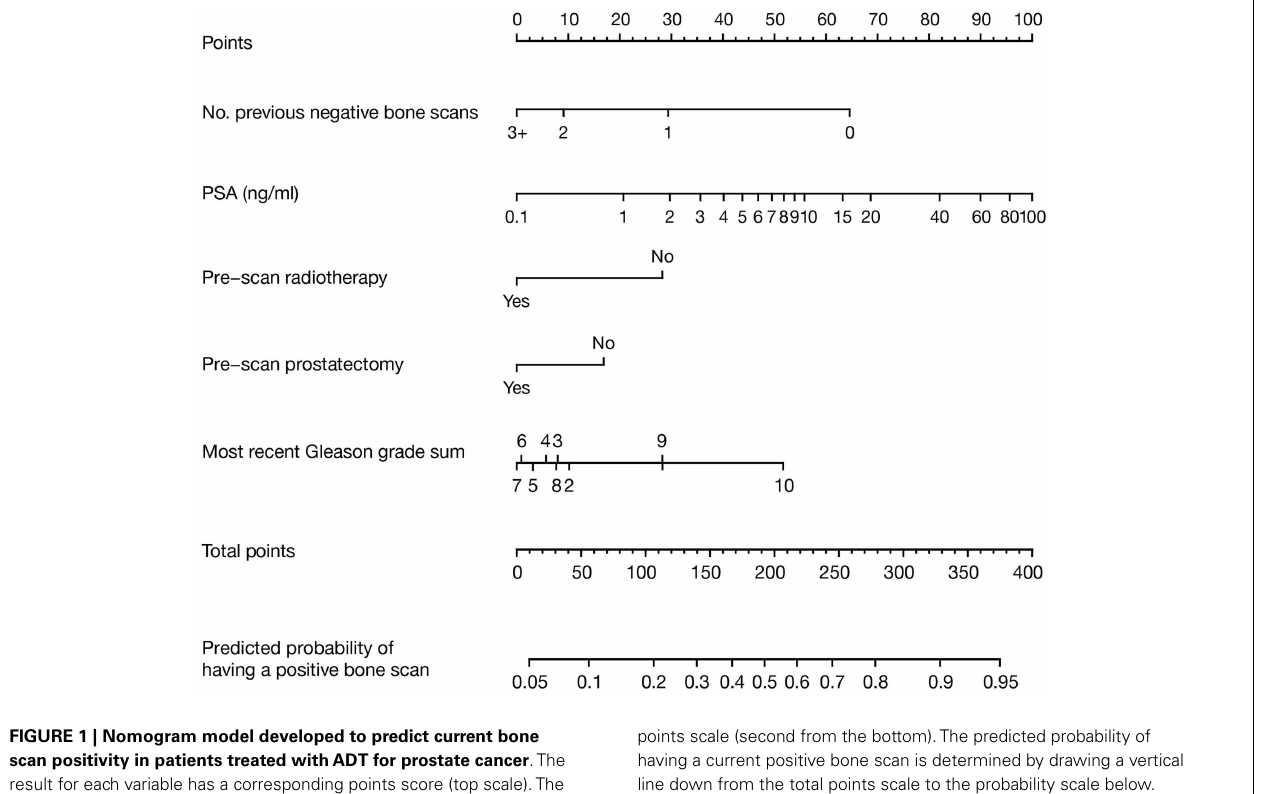
points scale (second from the bottom).The predicted probability of having a current positive bone scan is determined by drawing a vertical line down from the total points scale to the probability scale below. Number of previous negative bone scans should only include those after the initiation of